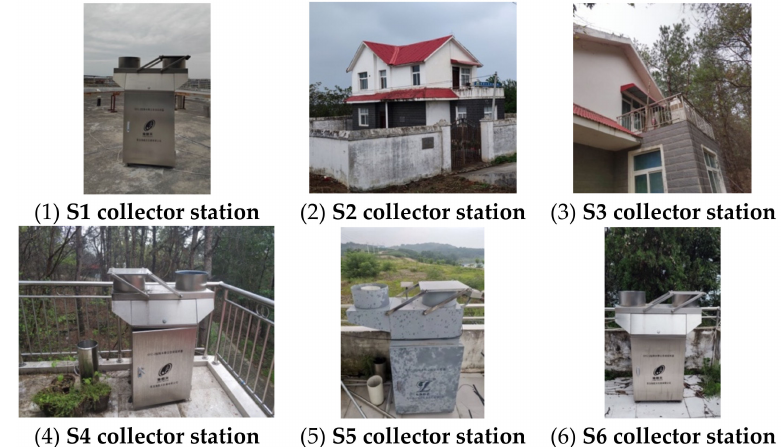
Figure 2. Nitrogen deposition sample